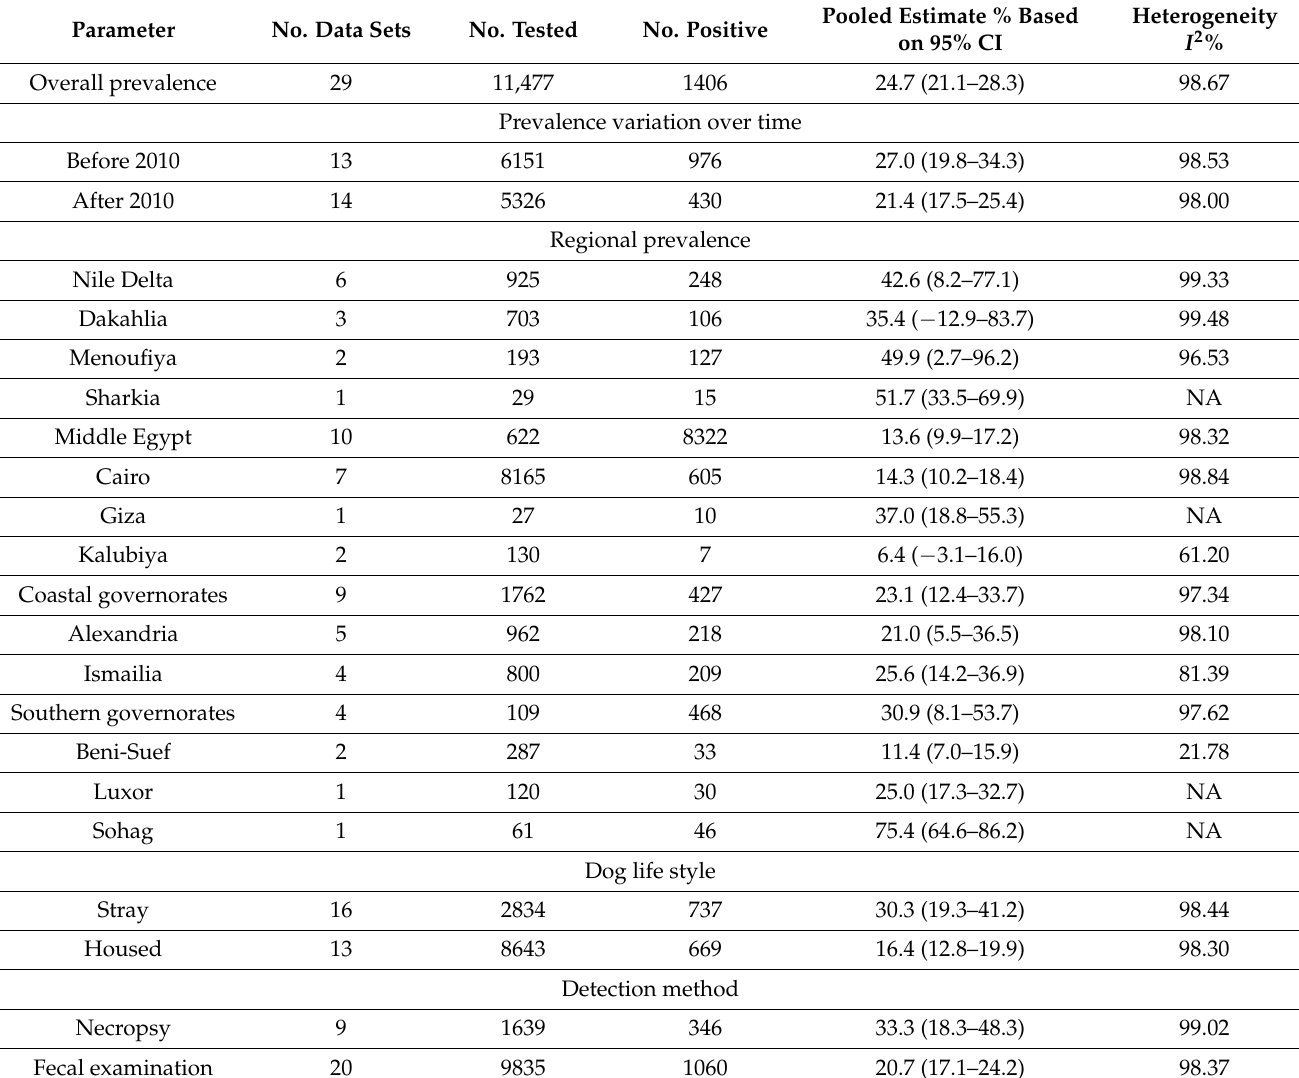
Table 3. Overall and regional pooled prevalence of Toxocara canis in dogs from various Egyptian regions, and variabilities according to dog life style and detection